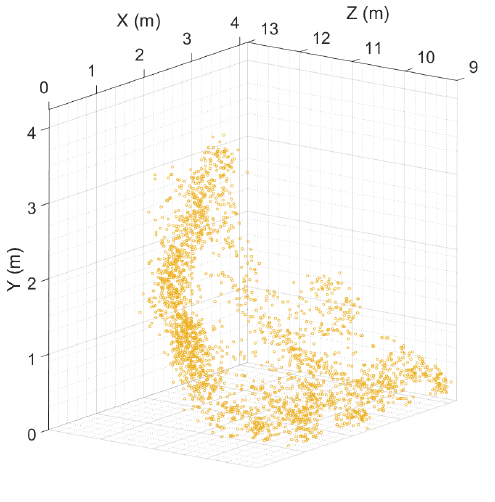
Figure 5. 3D fire